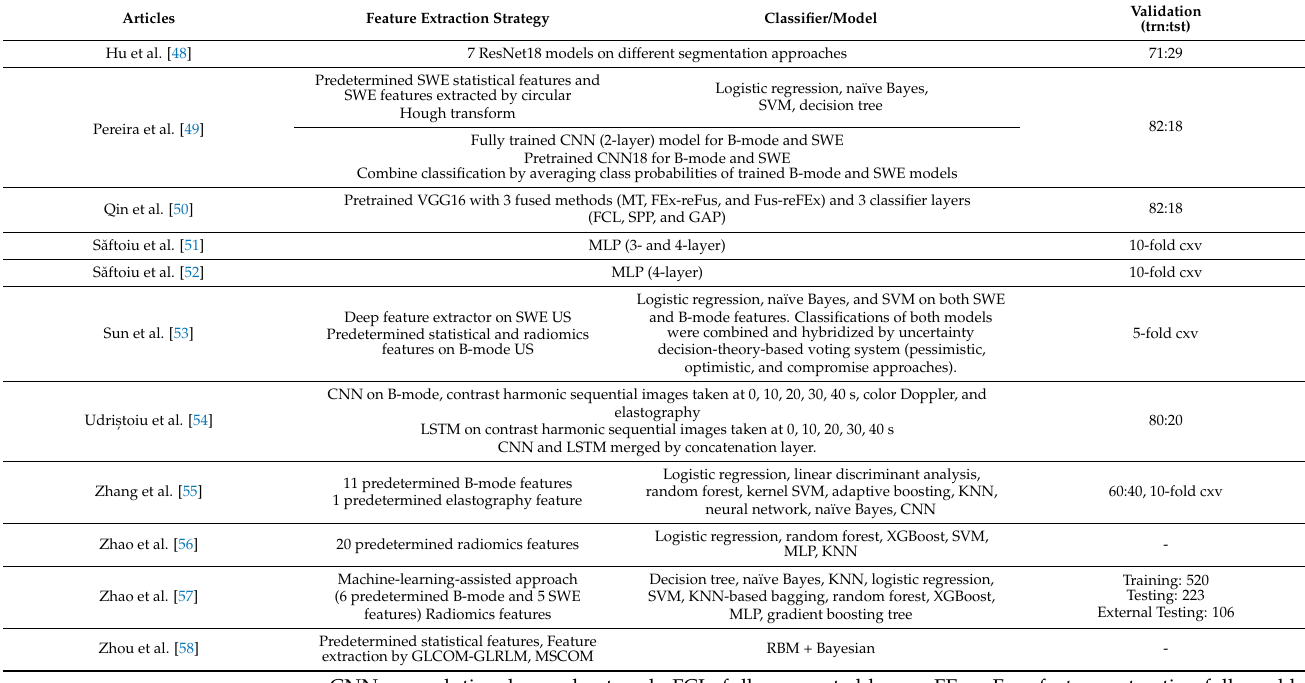
Table 3. Configuration of machine learning and classification